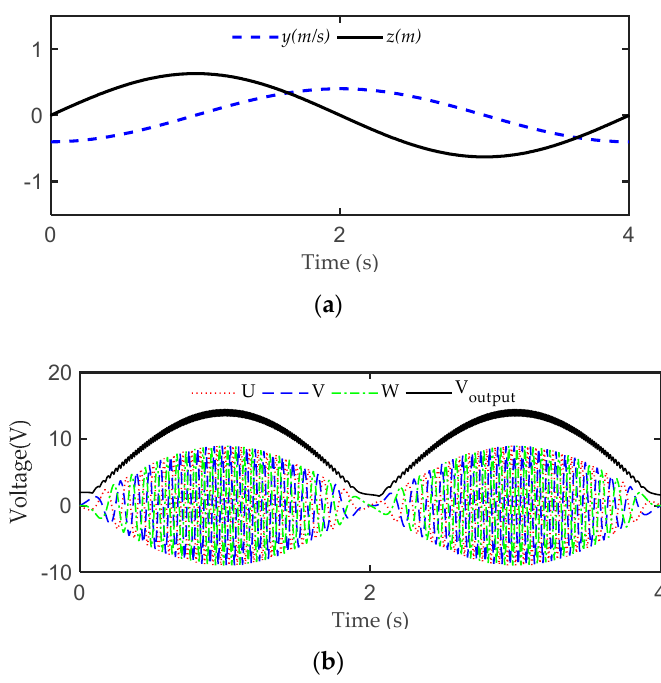
Figure 8. ( a ) Buoy movement; ( b ) Terminal voltage waveforms of WHD.